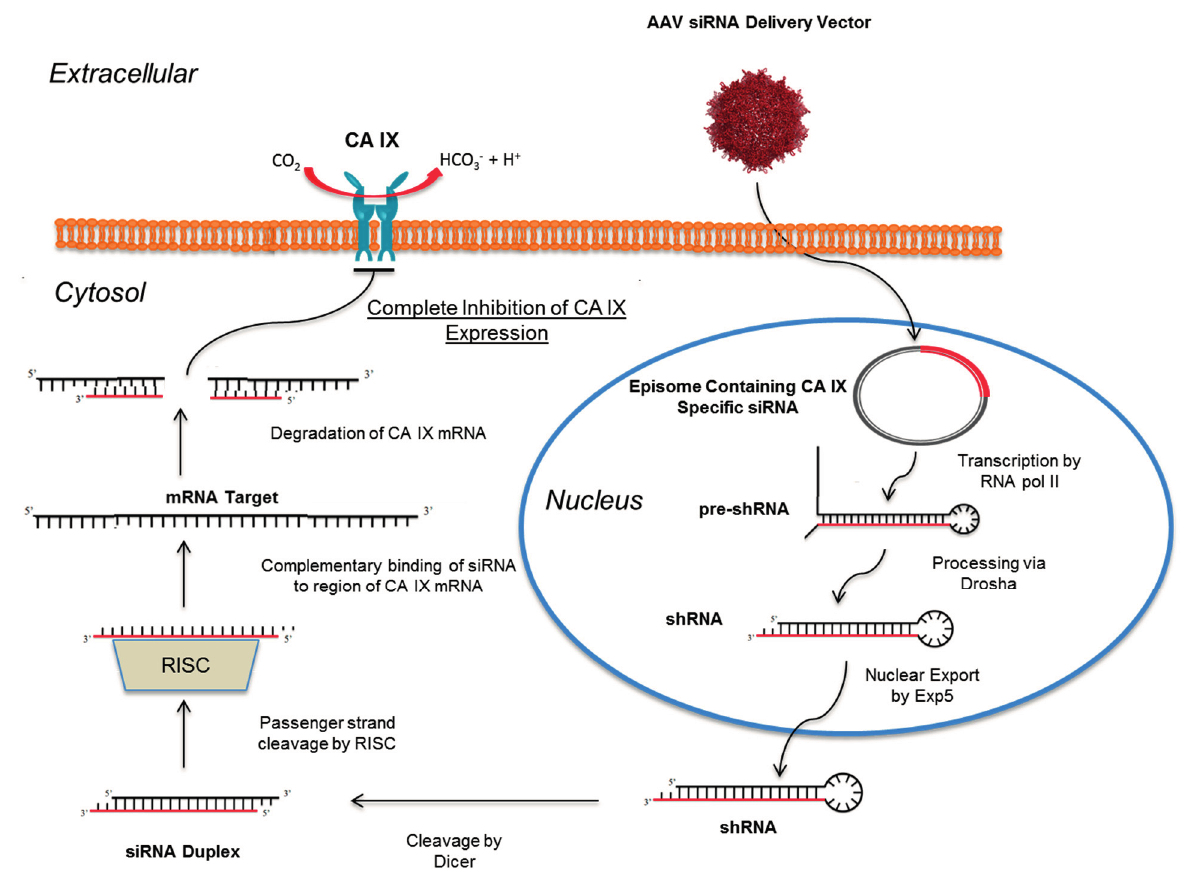
Figure 7. Pathway of AAV-mediated siRNA delivery to target CA expression in a tumor cell. The siRNA construct is delivered via a transduced AAV vector and its episome is trafficked to the nucleus. Within the nuclease the episomal DNA is transcribed by RNA pol II to produce a pre-shRNA construct that is further processed and transported to the